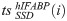
Performance of SSD and MSD on the NMR ensemble hIFABP.enzdes (blue lines) was executed for 1000 runs i for each of the ten conformations in the ensemble. For each number of runs i, the tsSSDhIFABP(i) value (dotted line) is the mean of the ten lowest-energy sequences (Eq 6). The corresponding nssrSSDhIFABP(i) value (solid line) is the mean recovery value deduced from the same sequences (Eq 5). MSF:GA:enzdes (orange lines) was carried out for 800 generations j on the whole ensemble using a population of 210 sequences. For each generation j, the tsMSDhIFABP(j) value (dotted line) is the mean of the ten lowest-energy sequences of the corresponding population (Eq 7). The corresponding nssrMSDhIFABP(j) value (solid line) is the mean recovery value deduced from the same sequences (Eq 5).